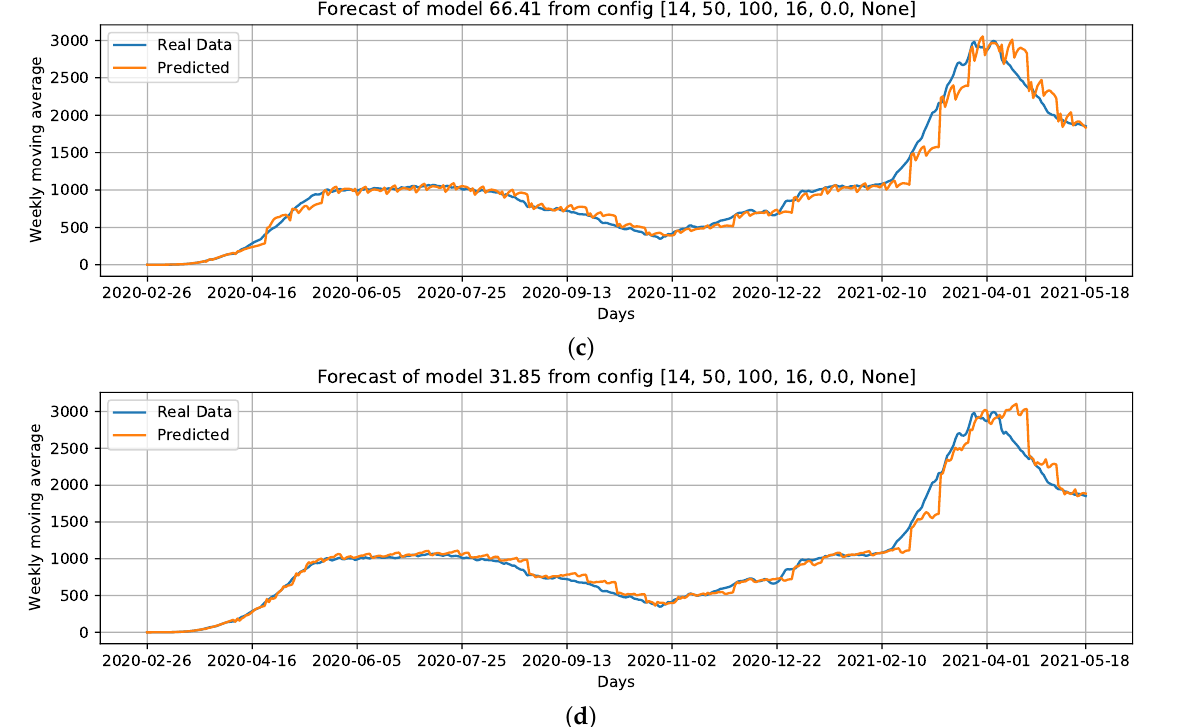
Figure 17. Curves of selected settings: Conf.1 : Cases, that is, our baseline case; considering which parameters can improve the baseline case, we select Conf.3 : Cases + R 0 ; without using Cases as an input feature, we select Conf.9 : R 0 + R e + Holiday flag, and; Conf.10 : PC 1 + PC 2 as input data. For these configurations, we draw the best curves (with the lowest RMSE) of each configuration over the test data. ( a ) COVID-19 daily deaths forecast using cases as input data. ( b ) COVID-19 daily deaths forecasts using Cases + R 0 as input data. ( c ) COVID-19 daily deaths forecasts using R 0 + R e + Holiday flag as input data. ( d ) COVID-19 daily deaths forecasts using PC 1 + PC 2 as input data.